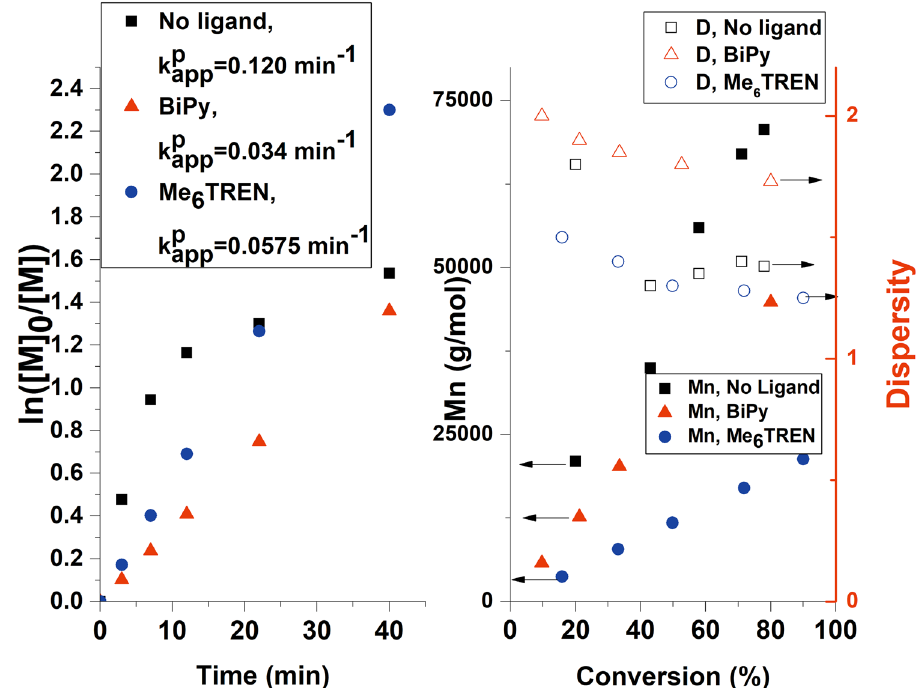
Figure 8. Kinetics plot for BA polymerization using CuNPs/SiO 2 catalyst and different